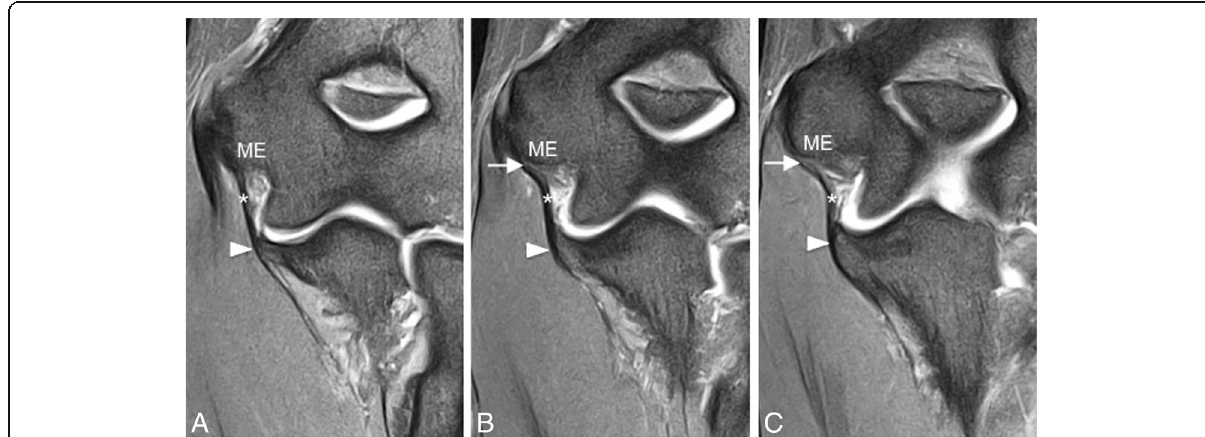
Fig. 5 Consecutive coronal FS PD-weighted MRI ( a – c ) showing the intact anterior bundle of the medial collateral ligament (A-MCL) complex (white asterisks). It extends from the inferior aspect of the medial epicondyle (ME) to the sublime tubercle of the ulna (white arrowheads). Note the typical striated appearance of the normal proximal A-MCL (white arrows)